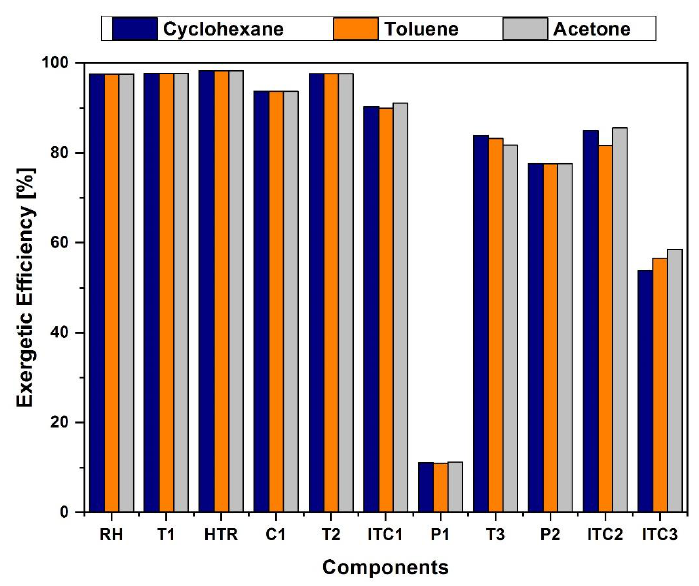
Figure 7. Exergetic efficiency of the Brayton S-CO 2 -ORC components.